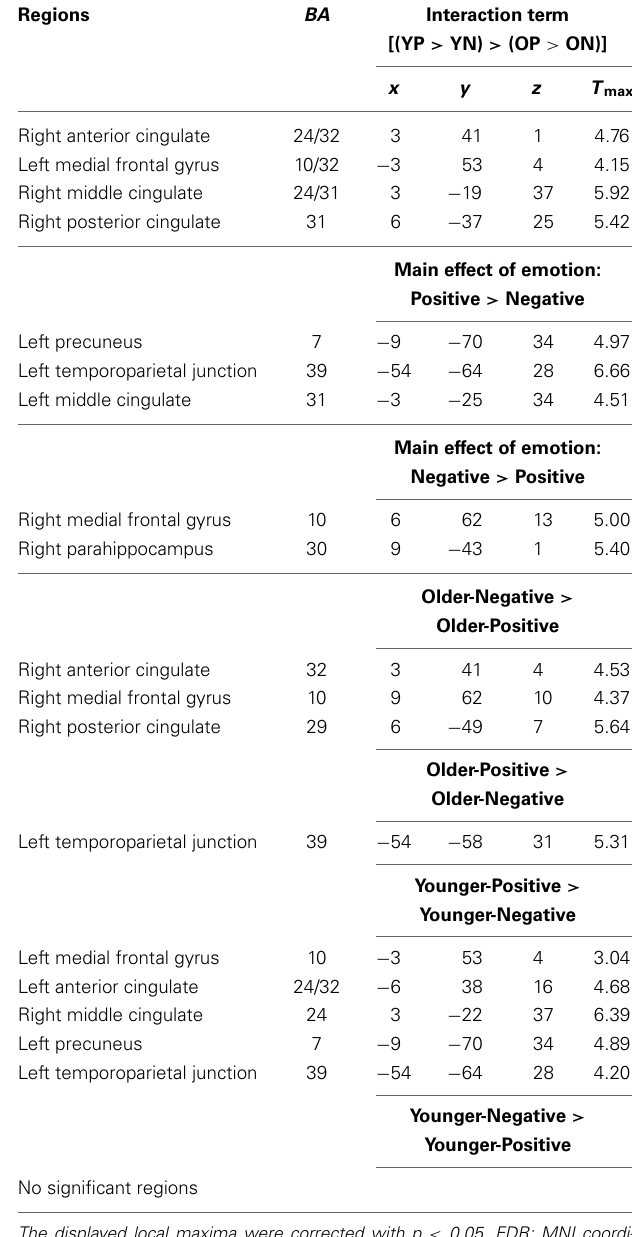
Table 3 | Relative increases in brain activity between older and younger adults during positive and negative autobiographical memory retrieval.